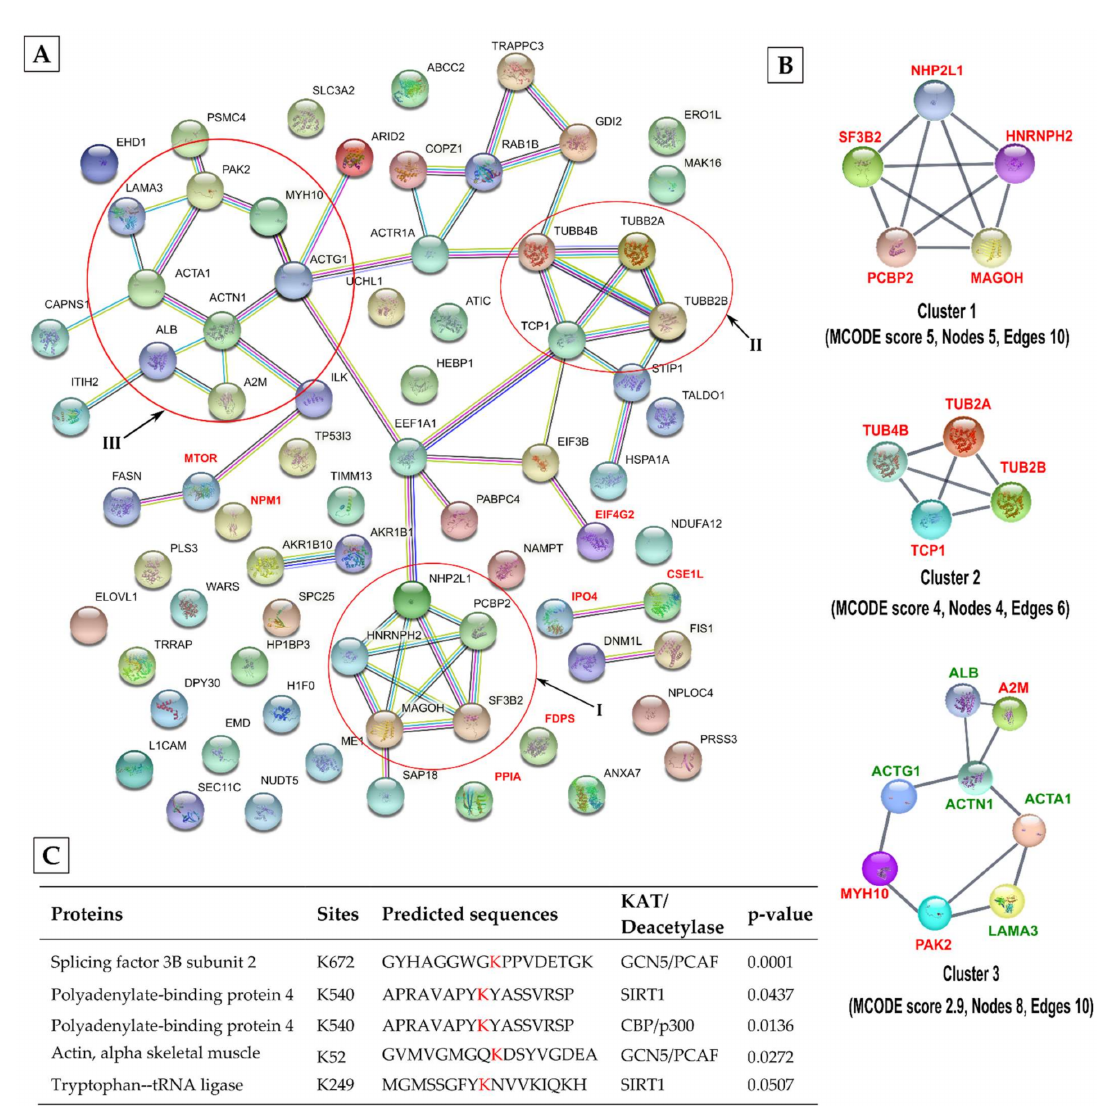
Figure 7. STRING functional protein association network of acetylated host proteins. ( A ) The identified acetylated host proteins from infected cells were analysed for functional protein association using the STRING database. Proteins are shown as nodes while the interactions are shown as edges. The association network contains 63 edges and 77 nodes with an average node degree of 1.64. The minimum required interaction score was set to high confidence ( ≥ 0.700) and PPI enrichment p -value was2.67 × 10 − 5 . Major clusters are encircled in red. ( B ) The three most highly ranked and tightly connected acetylated protein clusters were obtained by the MCODE algorithm using Cytoscape and ranked based on their MCODE scores. The proteins shown in red are known to be involved in influenza virus infection. ( C ) Prediction of identified acetylated sites (in red) to be acetylated or deacetylated by ASEB web